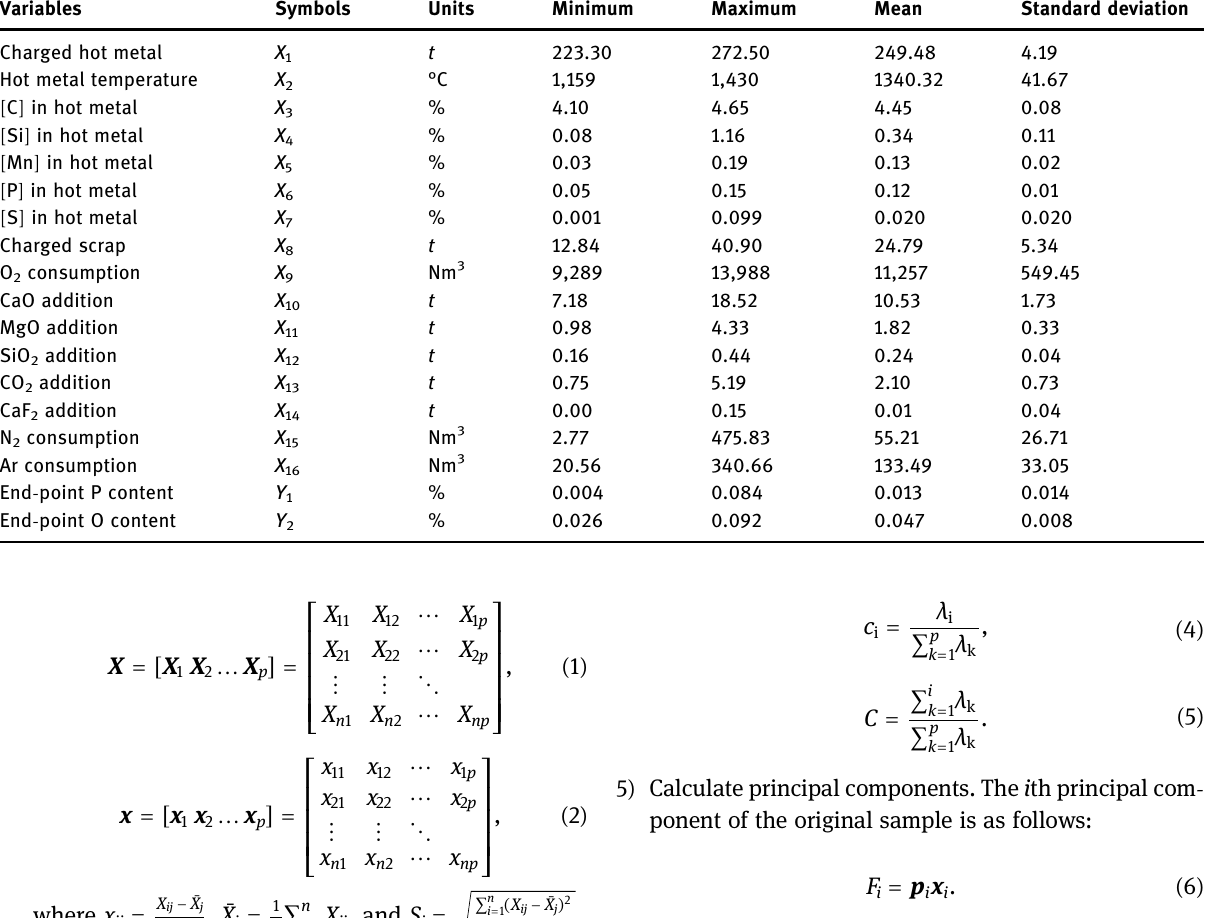
Table 1: Input and output variables of the model